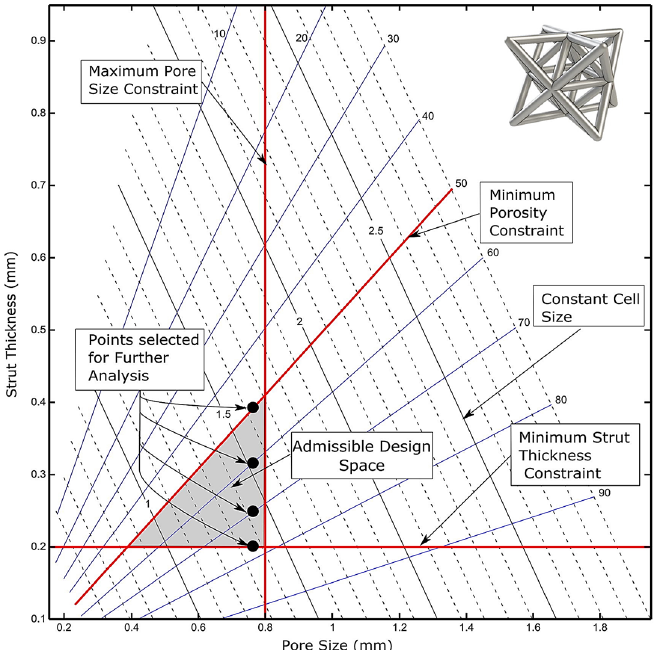
Figure 6. Design area for Octet truss with the constraints of manufacturing, pore size, and porosity. Reprinted with permission from ref. [84]. 2016, Elsevier Ltd.